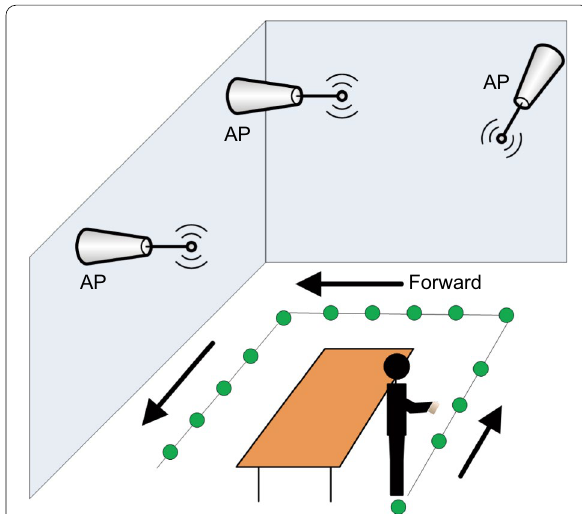
Fig. 2 The illustration of data collection in a testing area